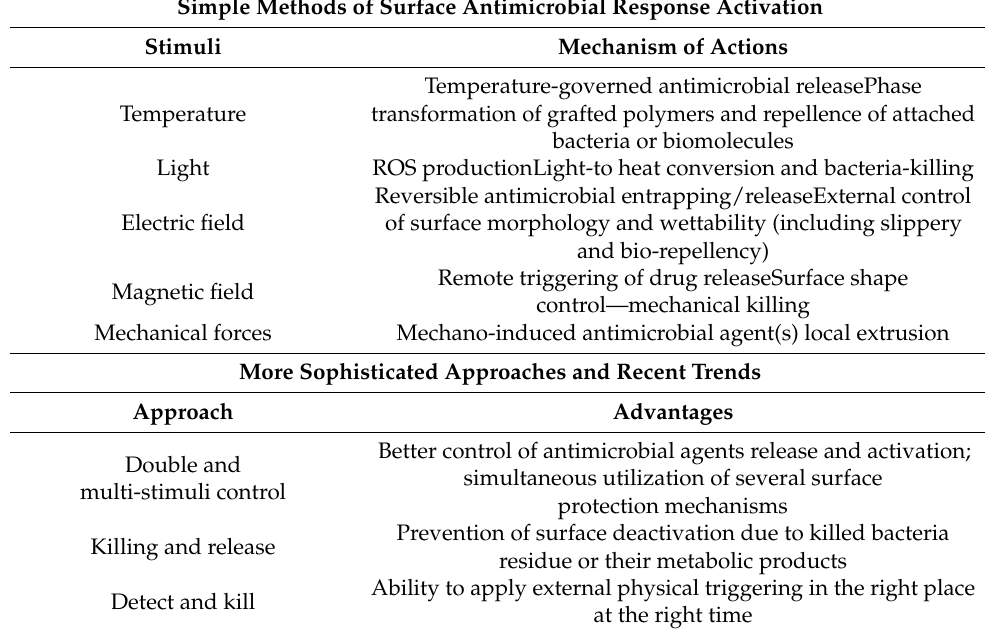
Table 1. Common methods of antimicrobial surface external activation by a physical stimulus and several recent more advanced